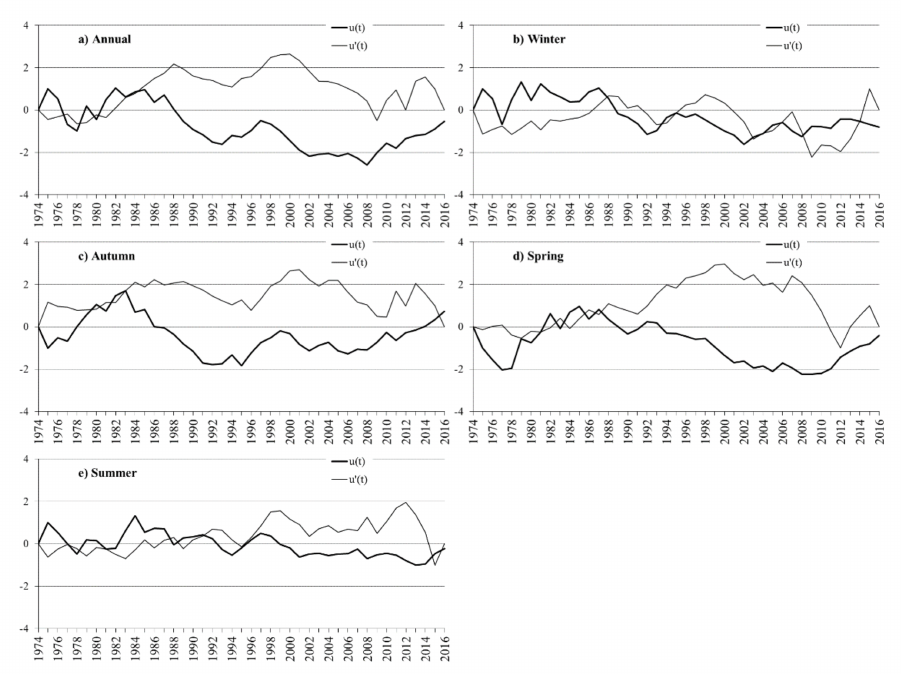
Figure 2. Graphical representation of the series u ( t ) and the retrograde series u ’( t ) of the sequential version of the Mann–Kendall test for ( a ) annual, ( b ) winter, ( c ) autumn, ( d ) spring, and ( e ) summer precipitations in the University Forest of Pertouli.